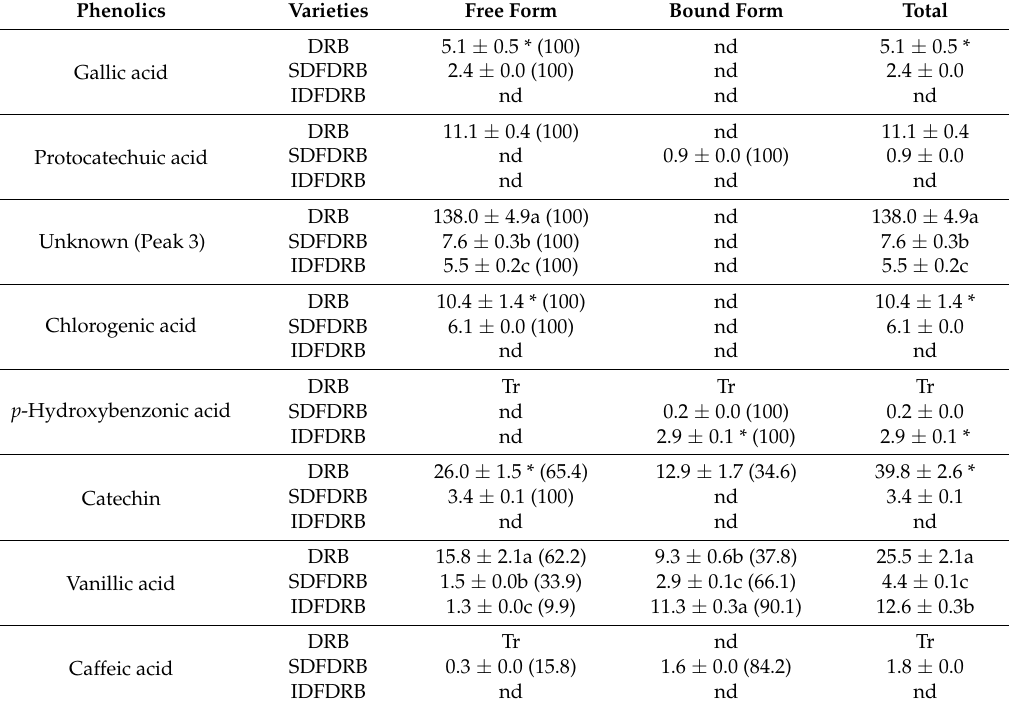
Table 2. Phenolic profiles of defatted rice bran and its dietary fibres ( µ g/g